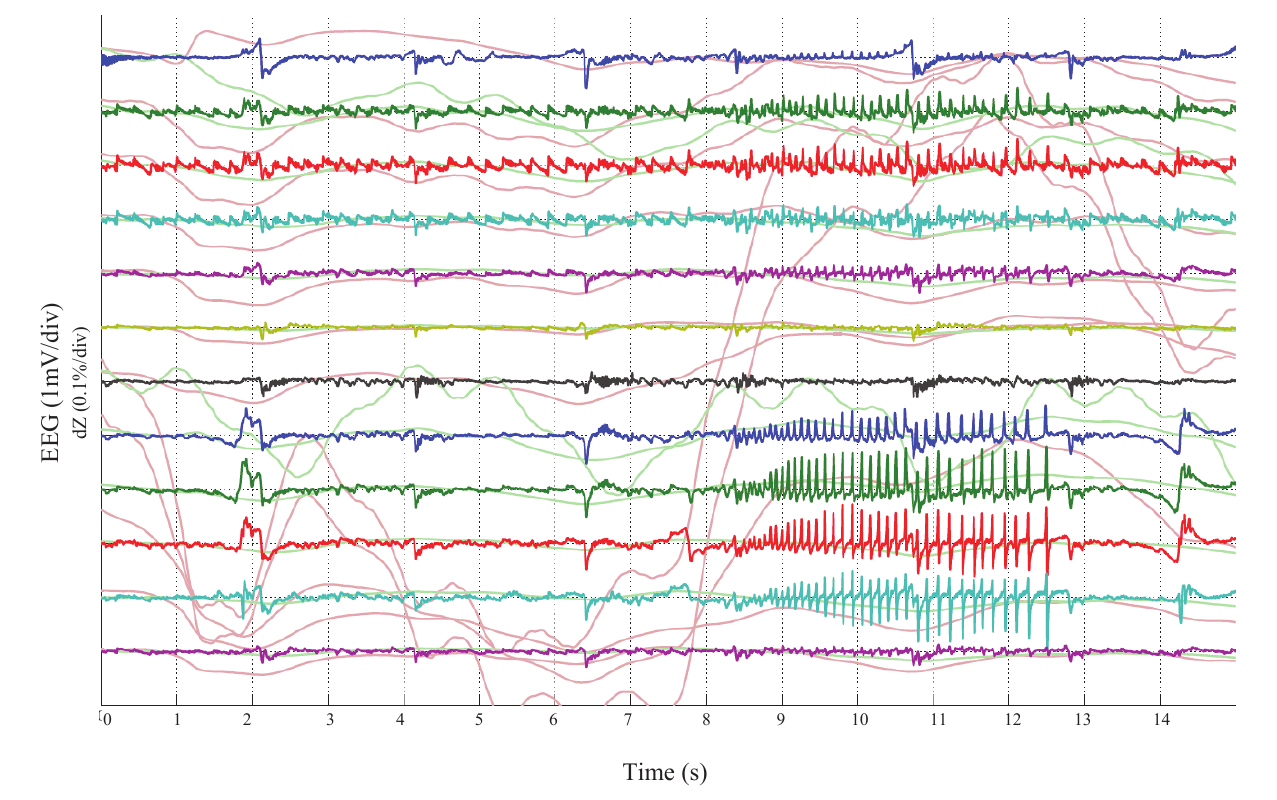
Fig. 8: Example of raw recorded data, recorded from the right hemisphere. Solid colours represent the EEG data. dZ values, from 2.2 kHz injection, are plotted